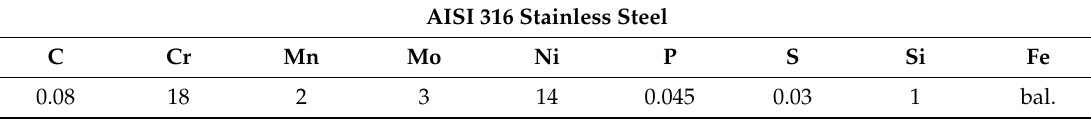
Table 2. Chemical composition of austenitic stainless steel (AISI 316) stainless steel (wt %) [21].